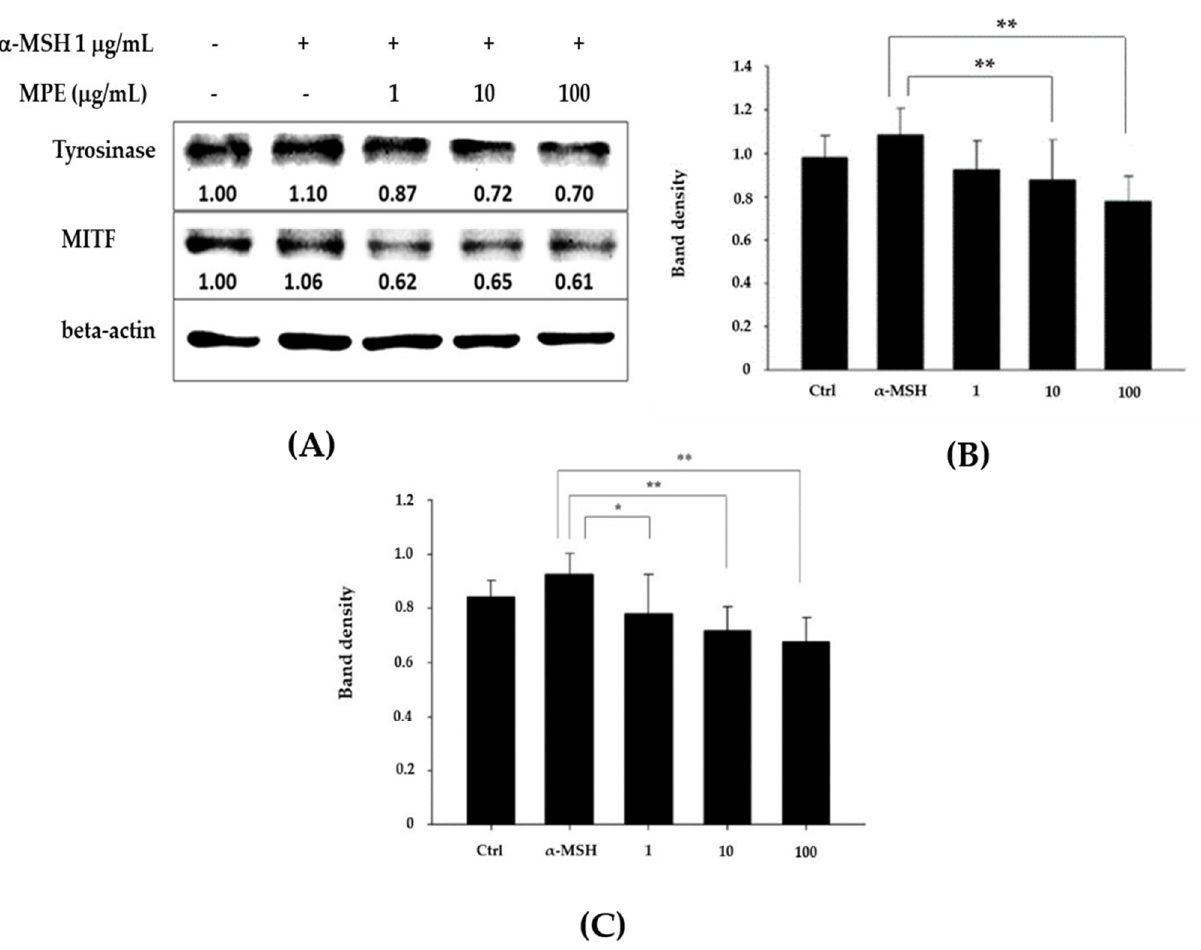
Figure 2. Tyrosinase and MITF protein expression levels after MPE treatment. Cells were treated with MPE at the concentration of 1, 10, or 100 µ g/mL for 24 h. ( A ) Western blot analysis was used for protein expression determination and beta-actin was used for comparison of protein expression by ImageJ software. ( B ) Tyrosinase protein expression (mean ± SD, n = 4). ( C ) MITF protein expression (mean ± SD, n = 5); * p < 0.01; ** p < 0.05.